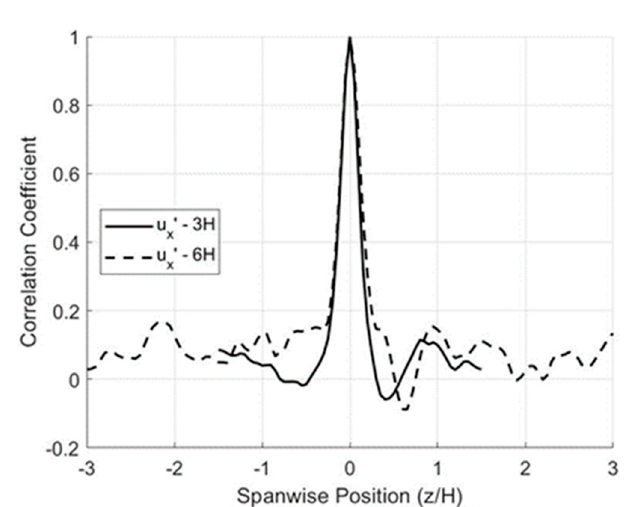
Figure 2. Two-point correlation of u (cid:48) x at 1H downstream of the step ( f ε = 0.667, f k = 0.2 )